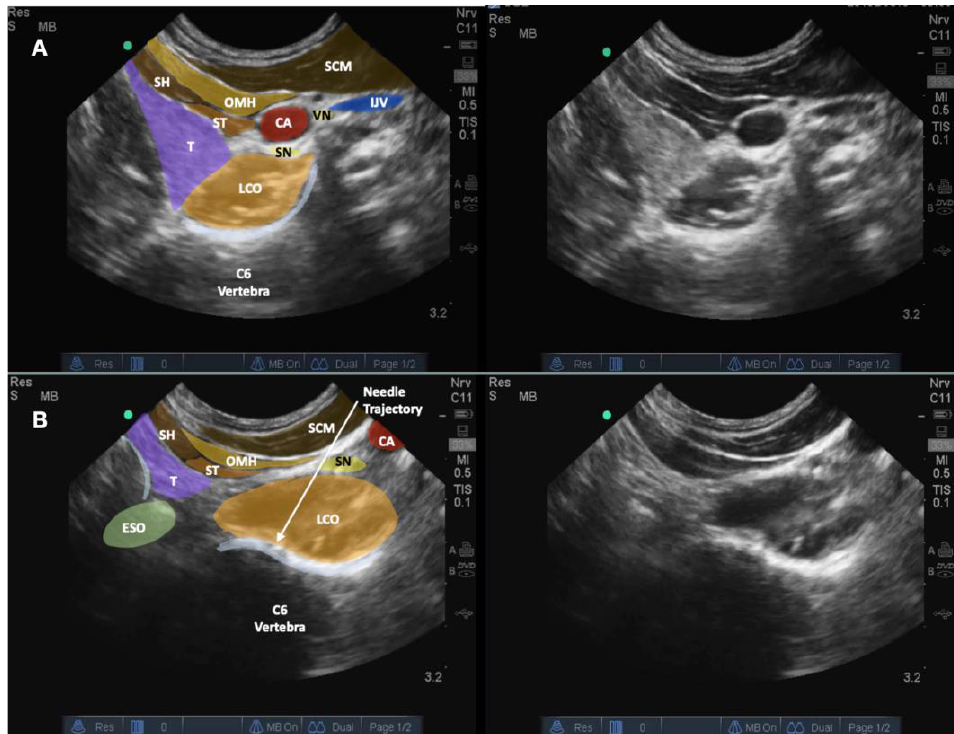
the sonoanatomy of the anterior cervical structures using a microconvex transducer before gentle transducer compression was applied. The image in ( B ) shows that with application of gentle down- ward pressure with the transducer; a fascial plane between the carotid artery and thyroid gland is usually created by separating these two important and potentially dangerous soft tissue structures, and the needle trajectory to approach the cervical disc can thus be better visualized and is safer.